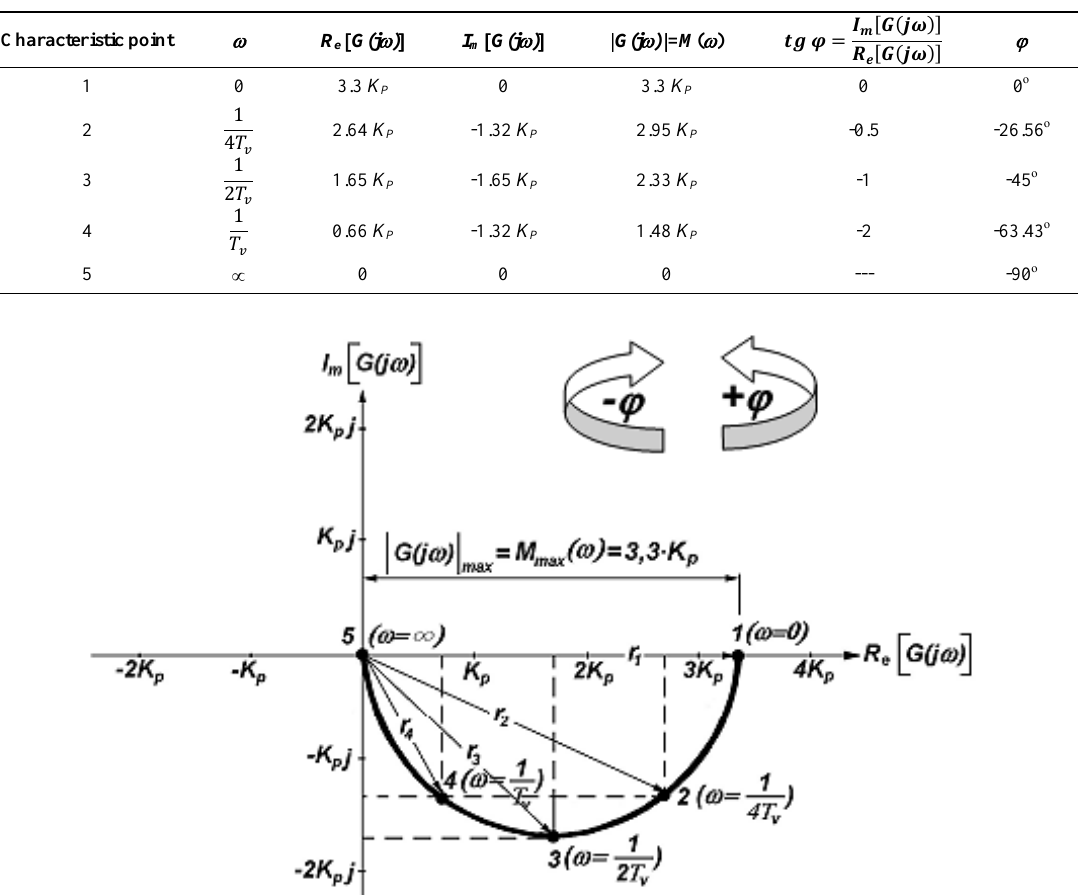
Figure 8. Polar diagram of the frequency characteristic G(j  ) of oscillatory transporting platform during the sieving of wet earth